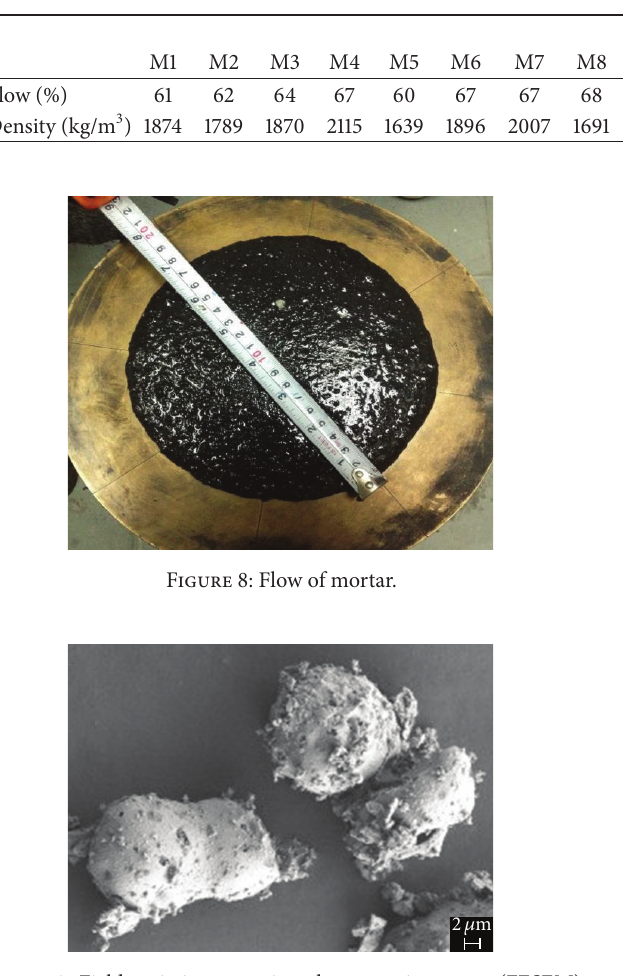
Figure 9: Field emission scanning electron microscopy (FESEM) images of POFA [2].